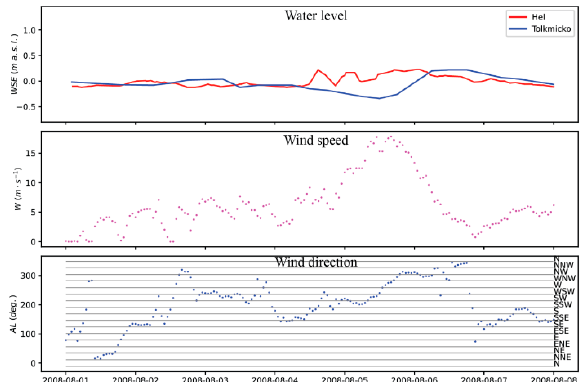
Figure 5. Water level (WSE) variation at Tolkmicko and Hel, wind speed and direction—the case (1–8 August 2008) in which wind originates from a westerly direction for a long period of time causes the water level at Tolkmicko to decrease in comparison to the water level at Hel (raw data; measurement frequency of WSE is 10 (min), wind data 1 (h)).